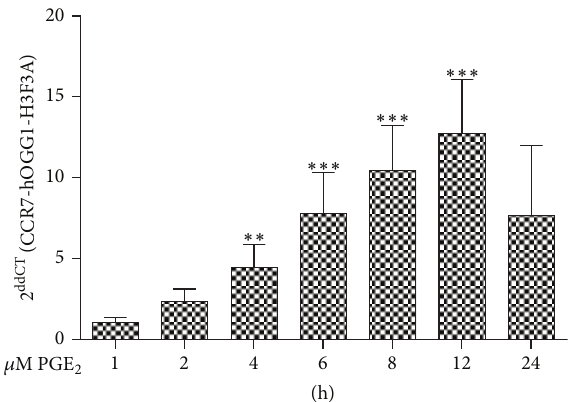
Figure 4: Stimulation with PGE 2 induces the upregulation of CCR7 mRNAonMDMM-1cells. Cellswerestimulated with 1 𝜇 MPGE 2 for the indicated times. Total RNA was extracted and submitted to real- time PCR to detect the presence of CCR7 mRNA. Data represent the means of four different experiments. ∗∗ 𝑃 < 0.005 , ∗∗∗ 𝑃 < 0.001 .